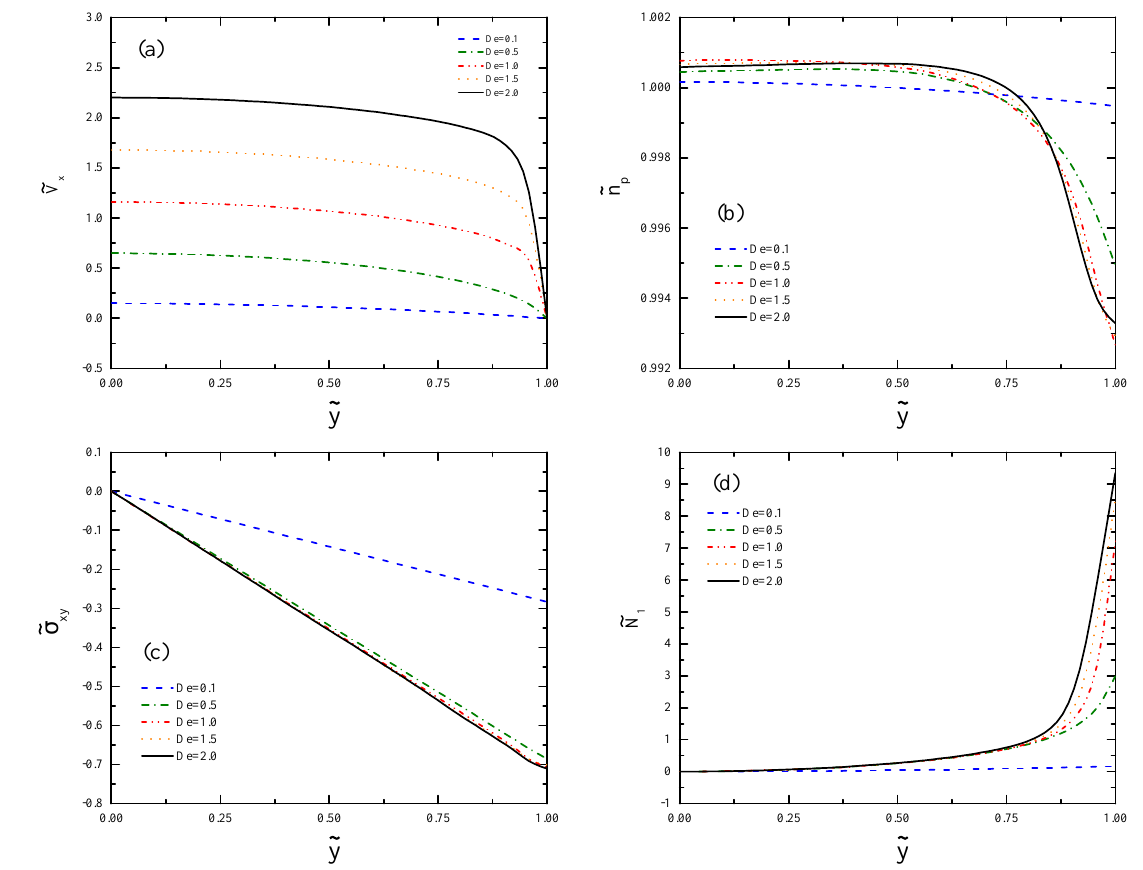
Figure 6. Profiles of ( a ) axial velocity, ( b ) polymer number density, ( c ) shear stress, and ( d ) first normal stress difference evaluated at ˜ x = 75 for different Deborah